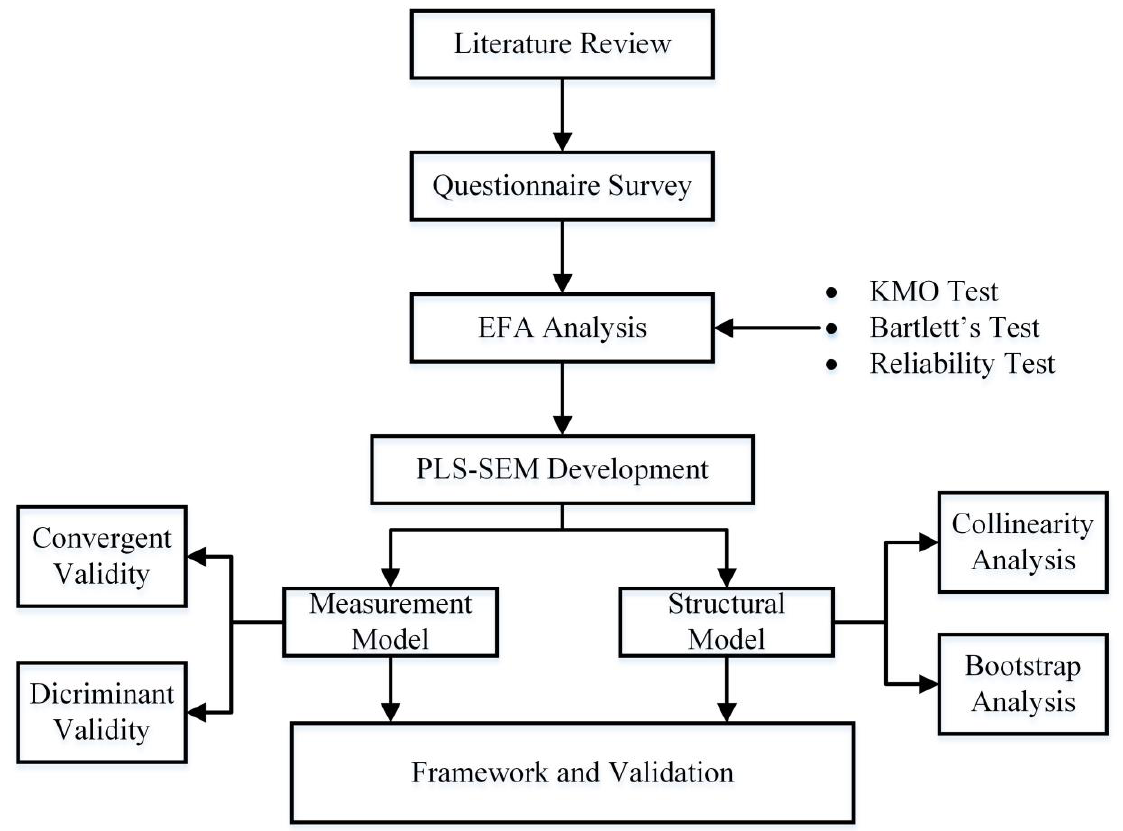
Figure 1. Research flowchart.